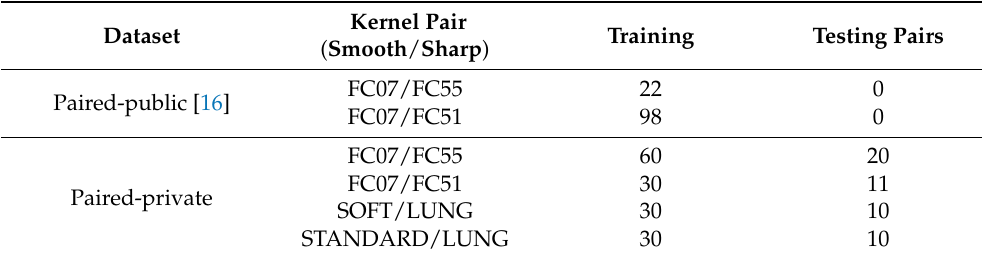
Training Testing